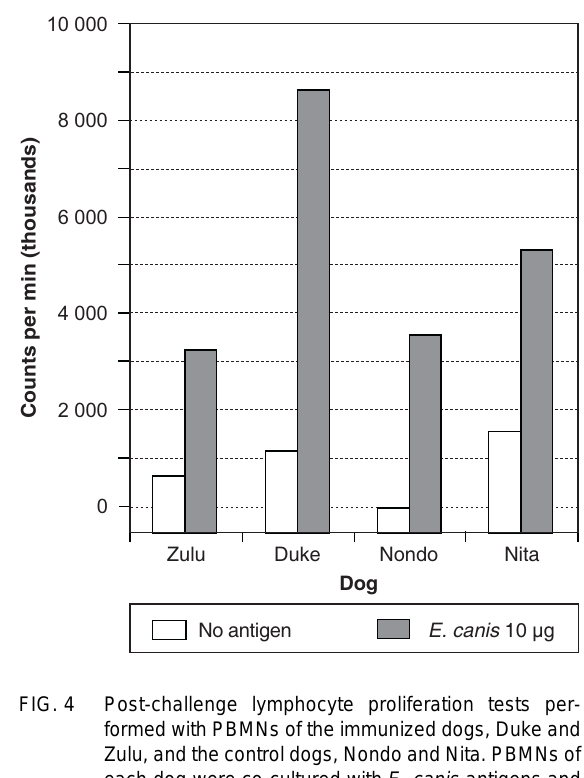
FIG. 4 Post-challenge lymphocyte proliferation tests per- formed with PBMNs of the immunized dogs, Duke and Zulu, and the control dogs, Nondo and Nita. PBMNs of each dog were co-cultured with E. canis antigens and proliferation was detected in PBMNs of all dogs in the presence of E. canis antigen at 10 µg of